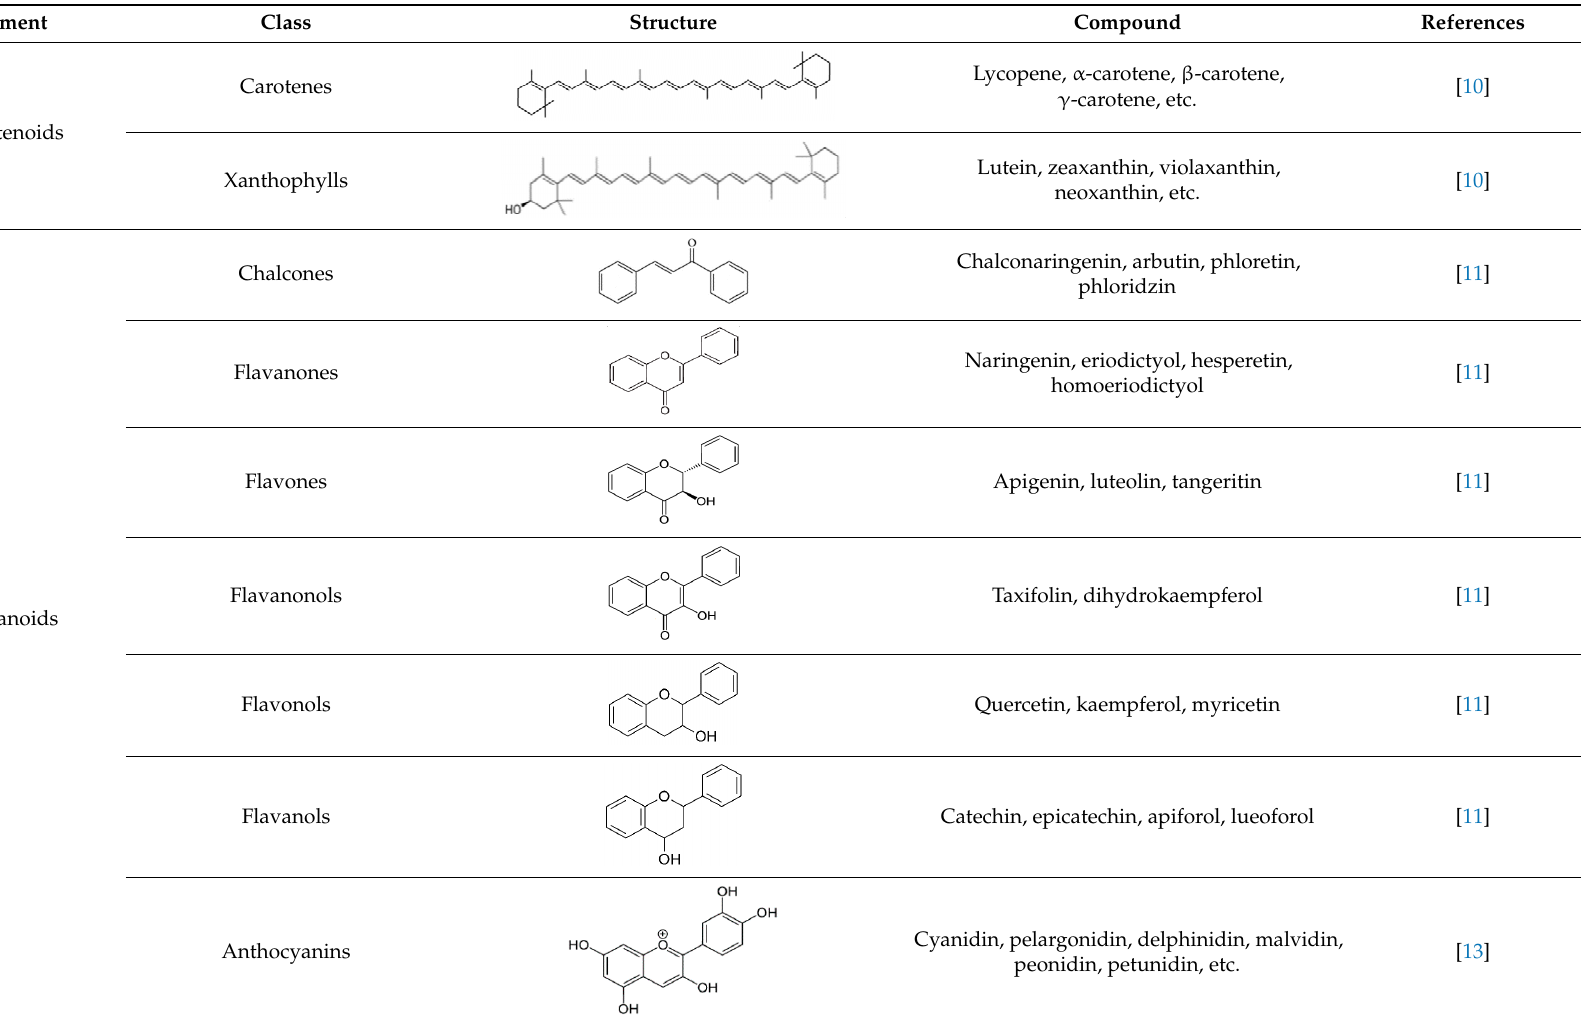
Table 1. Major pigments in plants that impart color to floral petals.